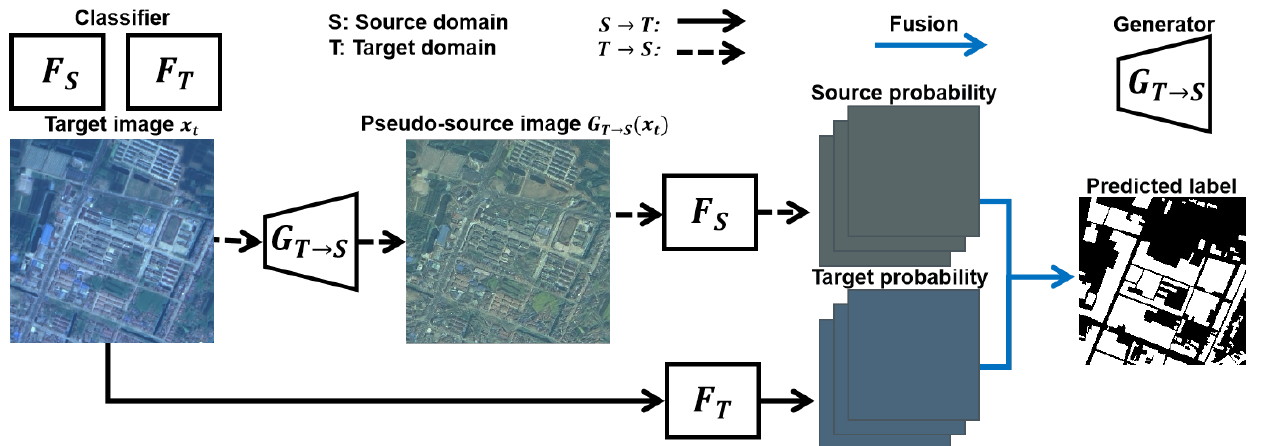
Figure 3. BiFDANet, test: the target classifier F T and the source classifier F S are used to segment the target images and the pseudo-source images respectively. And then the probability outputs are fused with a linear combination method and converted to the predicted labels.